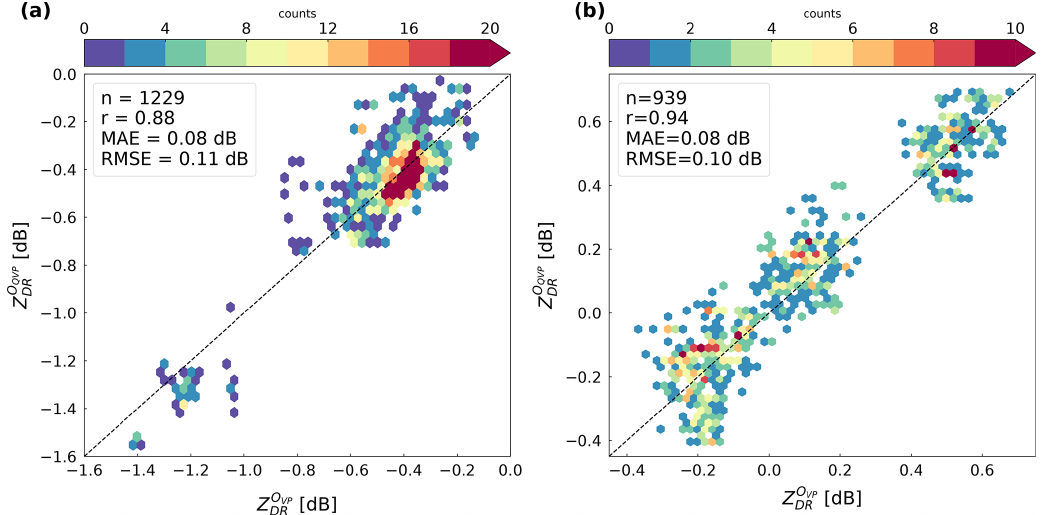
Figure 7. Comparison of Z DR offsets computed with QVPs and VPs. The scatter density plot shown in (a) provides metrics for evaluating the methods applied to the Chenies radar data set, whereas (b) shows the same as in (a) but for the Dean Hill radar data set.